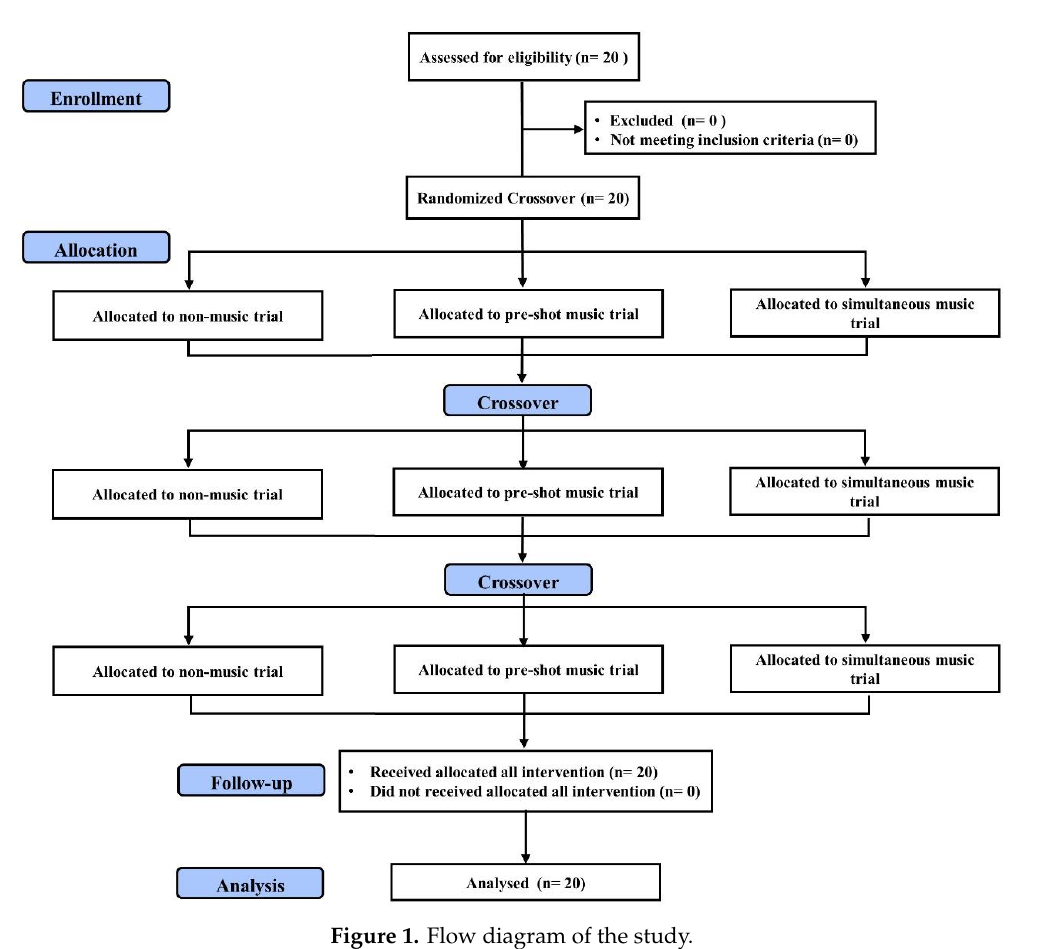
Figure 2. Illustration of experimental setting of golf performance and music interventions.